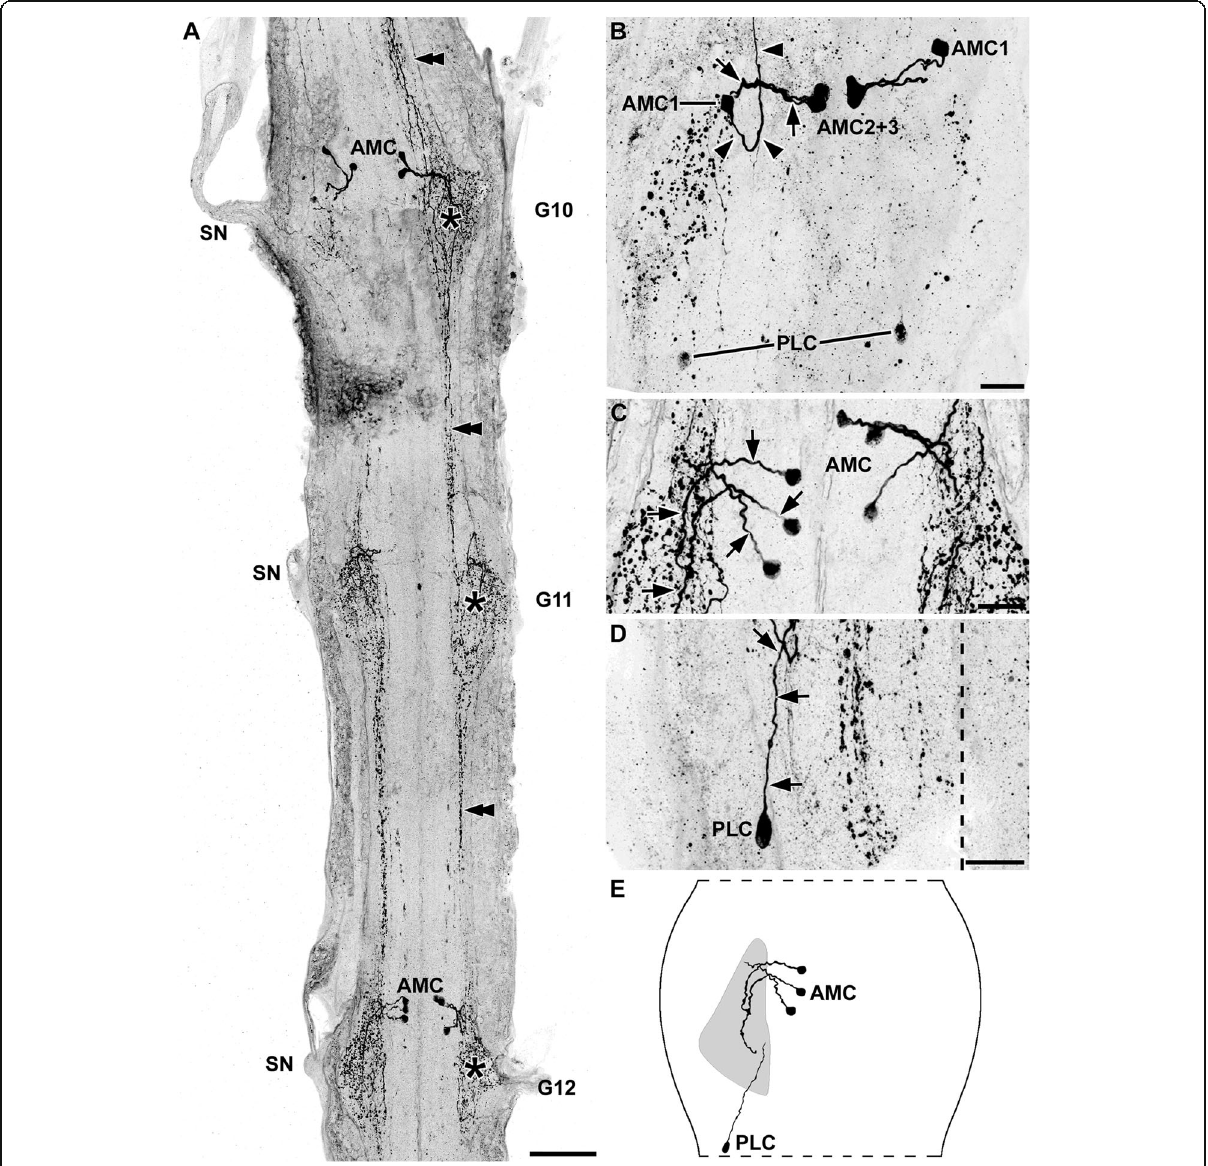
Fig. 6 Distribution and projection pattern of histaminergic neurons in the ventral nerve cord of Glomeris marginata . Maximum projections of cLSM stacks (ventral view, anterior to the top). a Overview of the ganglia 10 – 12 (G10 – 12), illustrating the rather homogenous structure of the ventral nerve cord. The ganglia could be distinguished from the connectives by the segmental nerves (SN). The ganglia contained the anteromedial cell bodies (AMC) as well as a conspicuous triangular neuropil, revealed by dense histamine-immunoreactivity (asterisks). A strongly labeled longitudinal tract could be observed throughout the ventral nerve cord (double arrowhead). b, c Besides the AMC, each ganglion contained a posterolateral soma pair (PLC). The three AMC can be subdivided in a single cell (AMC1) and two closely associated cells (AMC2 + 3). All AMCs projected laterally and posteriorly into the triangular neuropilar structure (black arrows in b and c). In rare cases, the AMC1 performed a loop, growing first posteriorly, but then looping back anteriorly before its signal got lost (black arrowheads in b). d The PLC projected anterolaterally toward the center of the ipsilateral hemiganglion (black arrows; ganglionic midline indicated by dashed line). e Reconstruction drawings of selected histaminergic neurons in a ganglion of the ventral nerve cord. The triangular histamine-immunoreactive neuropil is highlighted in grey. Abbreviations: AMC1 – 3: anteromedial cell bodies 1 – 3; G10 – 12: ganglion 10 – 12; PLC: posterolateral cell bodies; SN: segmental nerve. Scale bars: a: 100 μ m; b-d: 25 μ